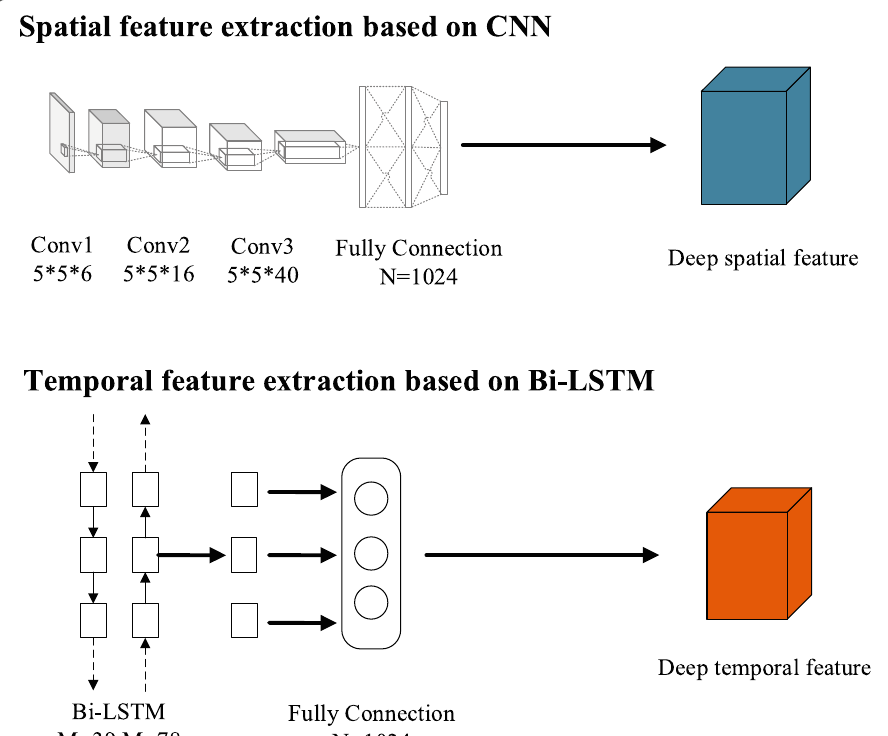
Fig. 2 PSTNN network structure diagram, including spatial feature extraction network and temporal feature extraction network, where M represents the number of nodes of LSTM, and N represents the number of nodes of